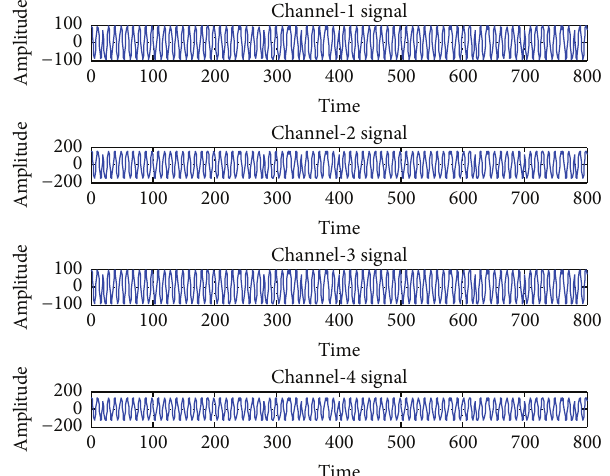
Figure 9: The received mixed signal waves after Gaussian channels. Four Gaussian channels are considered.